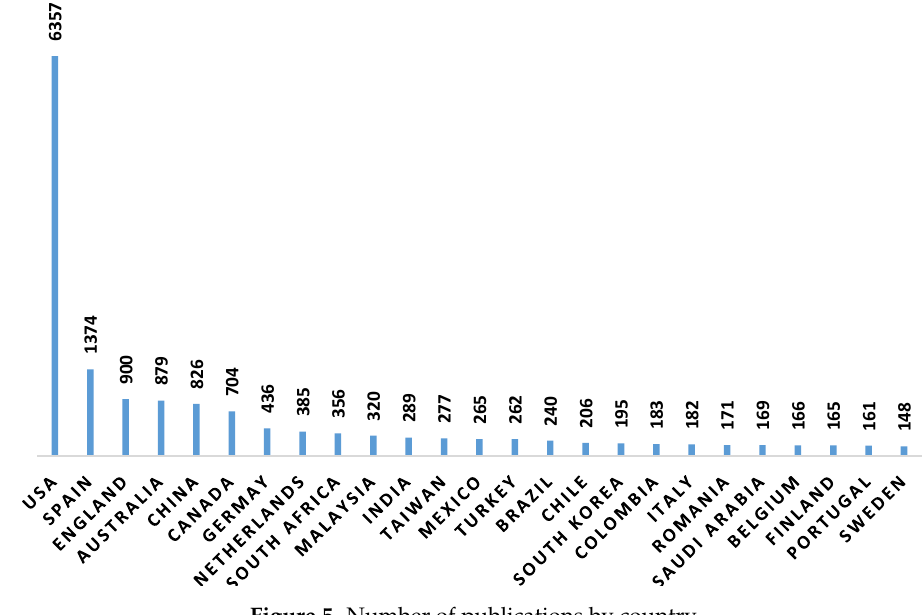
Figure 5. Number of publications by country.